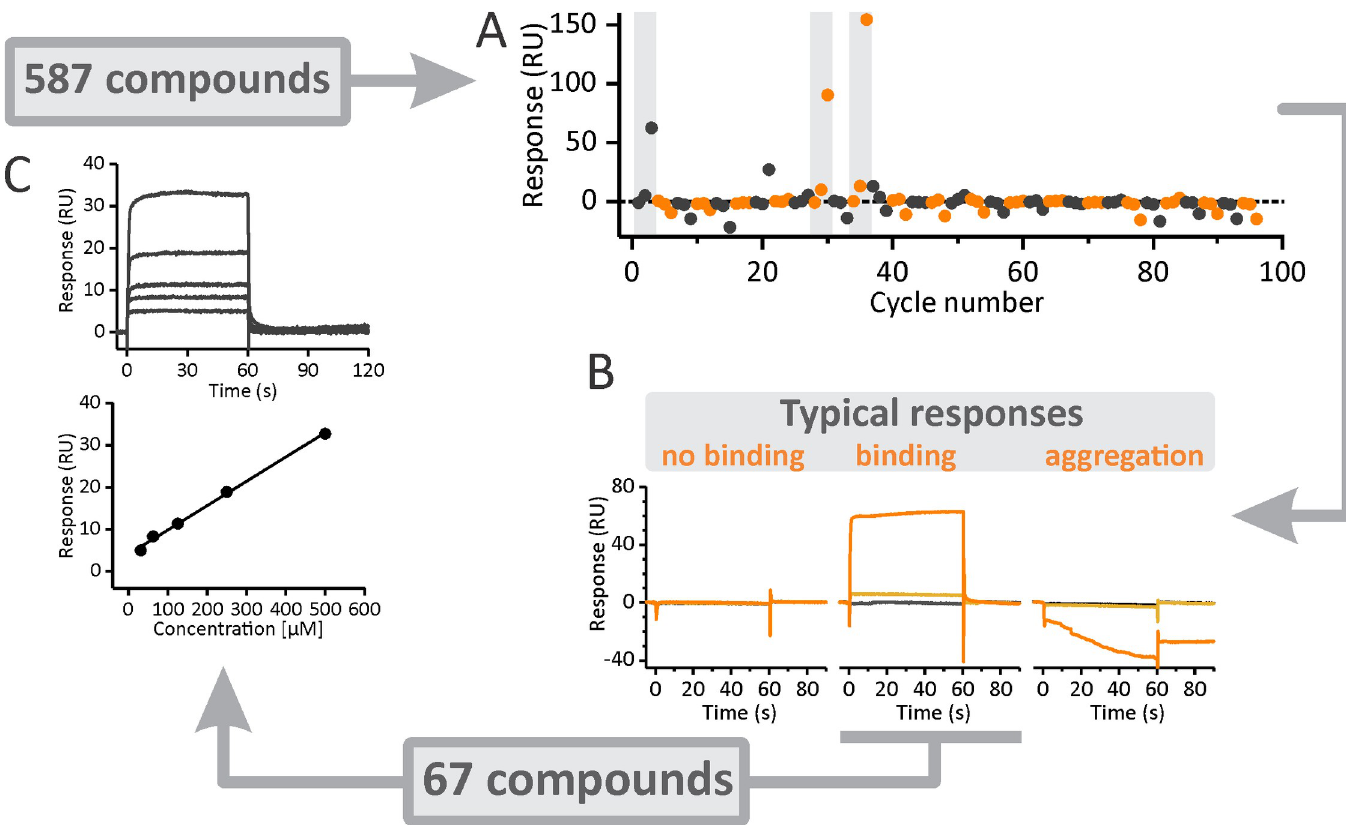
Fig 1. Surface plasmon resonance-based screening of compounds. (A) The binding of each compound to NLP Pya was initially tested at two concentrations, 20 and 200 μ M. A buffer control was injected in between different compounds. The dots represent binding responses 5 s before the end of each injection. (B) Sensorgrams were used to obtain the data in (A) and are presented for the buffer injection (black), 20 μ M compound (light orange), and 200 μ M compound (dark orange). Typical responses included no binding at any concentration (left), aggregation of compounds at the higher concentration (right), or concentration-dependent binding (middle). (C) Afterwards, 67 compounds that exhibited concentration-dependent binding to NLP Pya were further screened at an extended range of concentrations. The titrations shown are for the compound 5D11 [61], which was titrated with concentrations ranging from 31 to 500 μ M (from the bottom to the top in the upper graph). 5D11 does not exhibit saturated binding for the tested concentration range (bottom graph). The line is a linear fit to the responses obtained from the sensorgrams presented in the upper panel (5 s before the end of the injection).